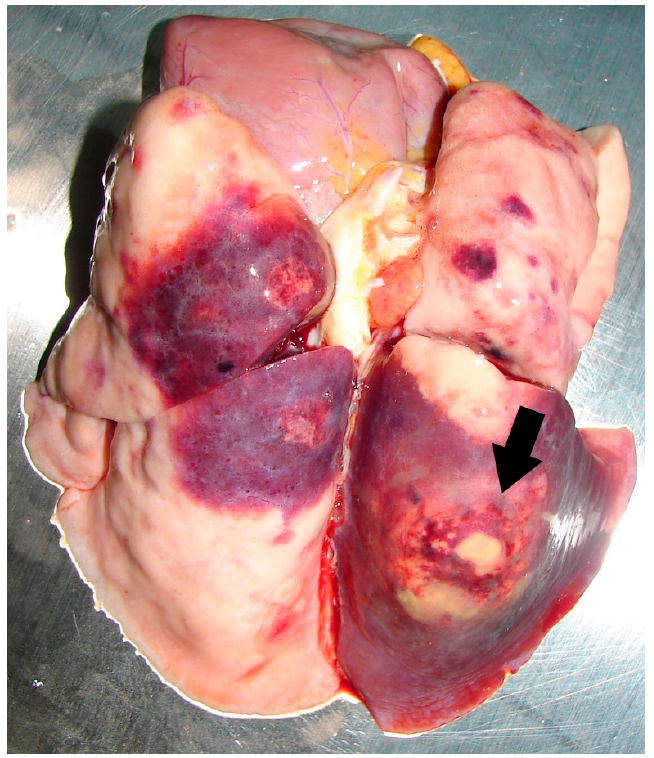
Figure 3. Large abscess in the left caudal lung lobe (black arrow) of a Douc langur with melioidosis.